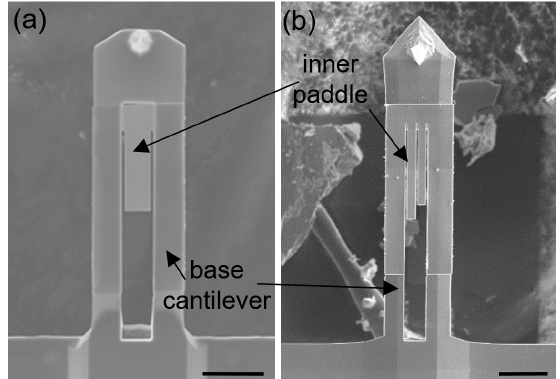
Figure 13. SEM images of AFM cantilevers with single ( a ) and double ( b ) inner paddles which are formed by micro-LEGO and focused ion beam (FIB) milling. Both scale bars represent 20 m. Reproduced with permission from [116].